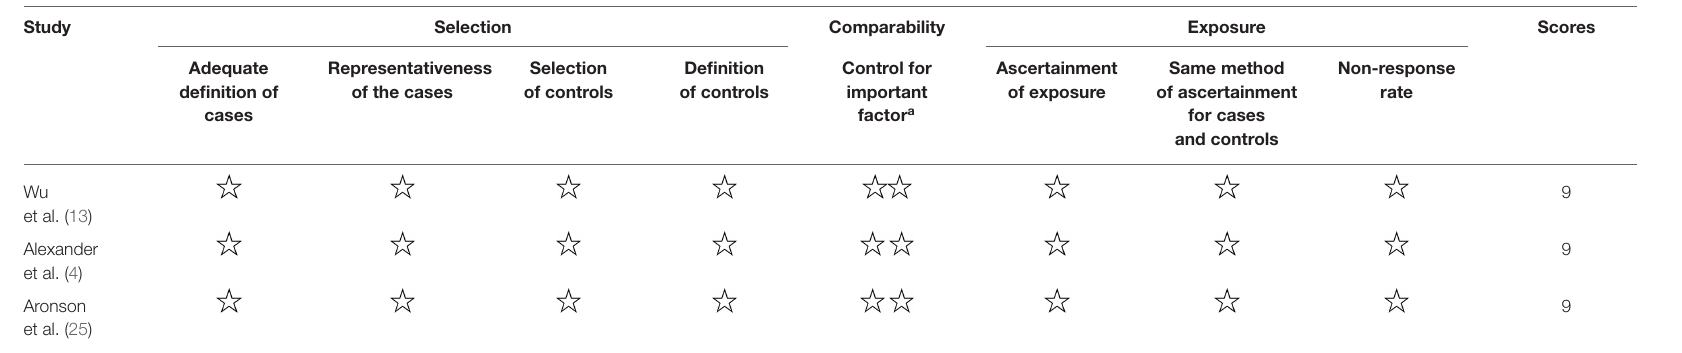
TABLE 2 | Results of quality assessment using the Newcastle-Ottawa Scale for included studies (Cohort